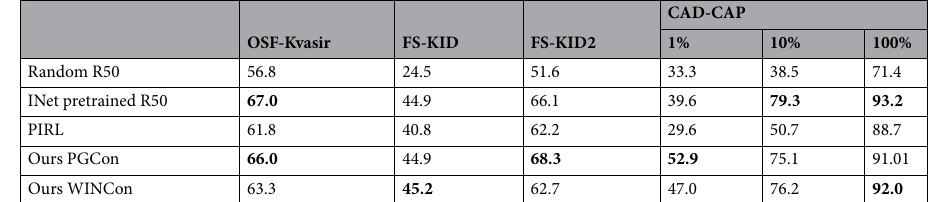
Table 3. Top-1 linear n-way classification accuracy (n being the number of classes) evaluated with a linear classification head (2- fc layers) over frozen encoder weights on datasets OSF-Kvasir, FS-KID, FS-KID2 and CAD-CAP. All results are with the R50 encoder. Significant values are in bold.